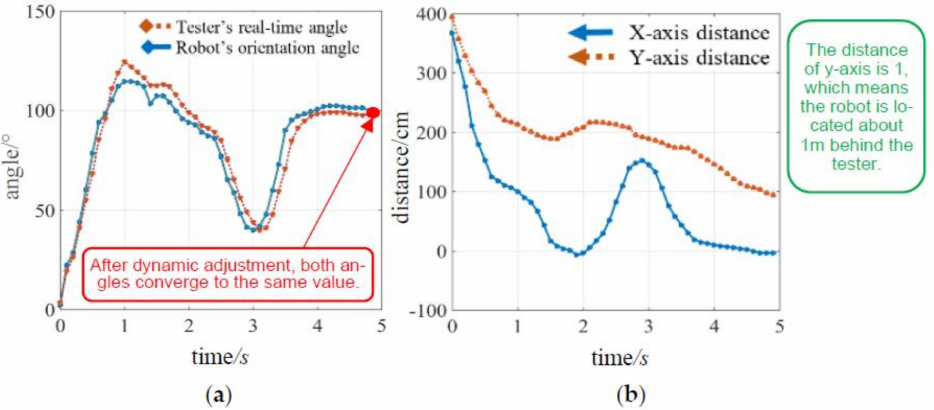
Figure 12. The orientation angle and the relative position of the robot and the tester in the path- tracking experiment. ( a ) The blue data are the robot’s orientation angle and the red data are the tester’s real-time angle. ( b ) The data are the x -axis distance and y -axis distance between the robot and the